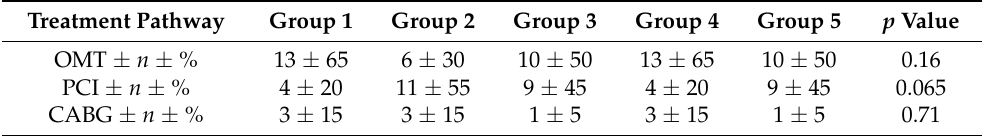
Table 4. Treatment pathway after diagnostic